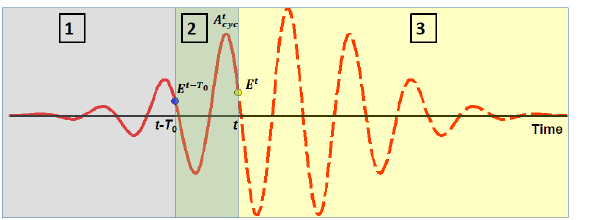
Figure 2. A sketch of time profile of electric field at a fixed space point. Time point t is the current point where electric field E t is evaluated from the FDTD equations. Areas 1 and 2 contain the time points where electric field has been evaluated by the FDTD method. Area 3 contains the “future” time points where electric field will be evaluated at later steps. Area 2 is the full cycle that is the nearest to the current time point t